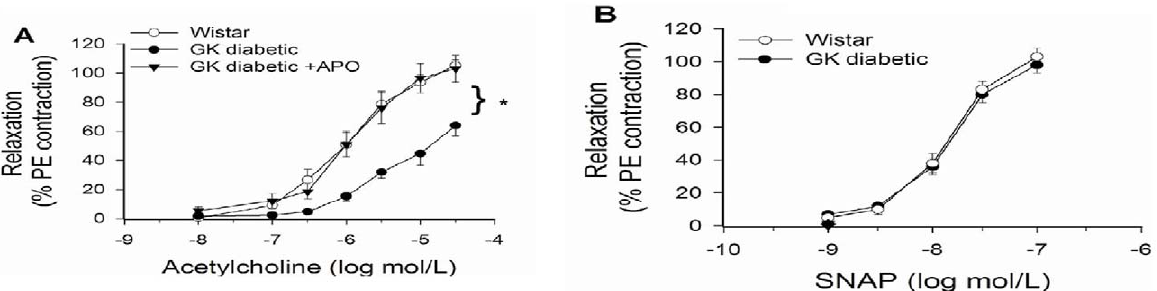
Figure 5. Apocynin restores vasorelaxation of the diabetic aorta. A. Diabetes significantly decreased acetylcholine-induced dilation $ 1 m M in GK compared to Wistar. Apocynin (APO) was used to inhibit NADPH-dependent generation of superoxide. B. Diabetes did not alter the response to SNAP (a nitric oxide donor). Values are mean 6 SEM of 5 animals. * p , .05 compared to Wistar.